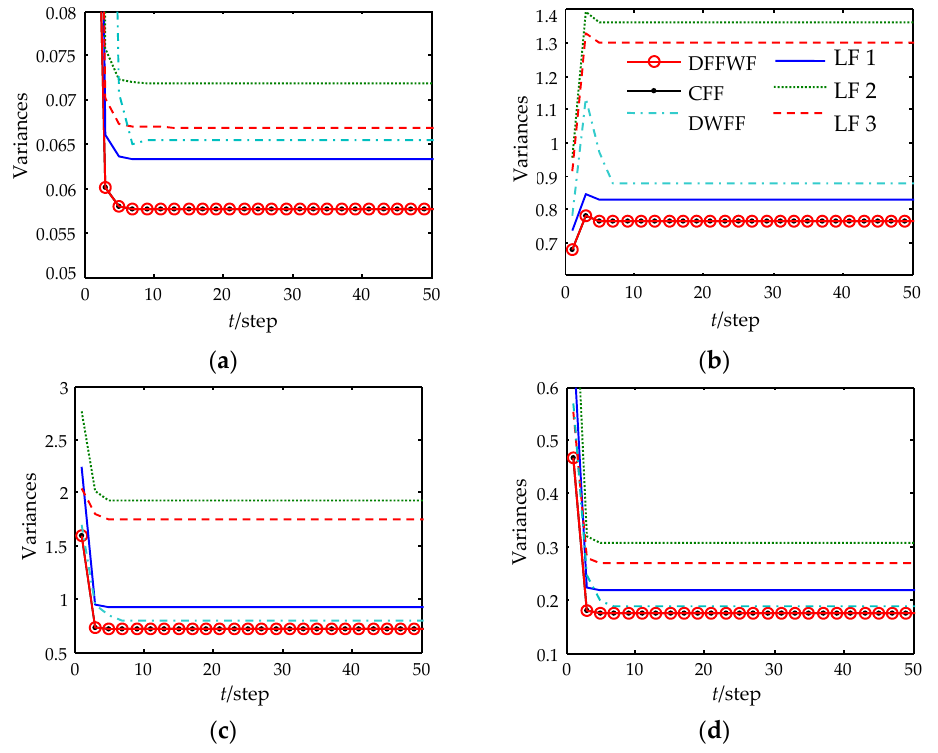
Figure 3. Filtering error variances of DFFWF, CFF and all local filters. ( a ) The first state component. ( b ) The second state component. ( c ) The third state component. ( d ) The fourth state component.